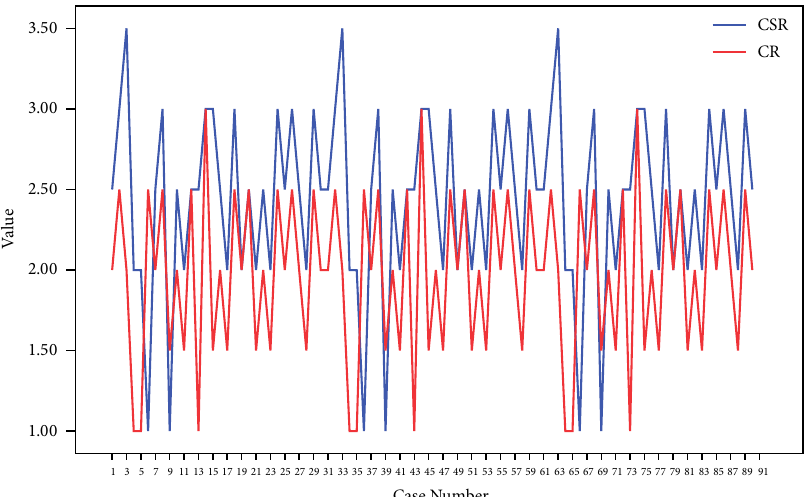
Figure 8. CSR – CR relation in Case MON (source: own calculations)